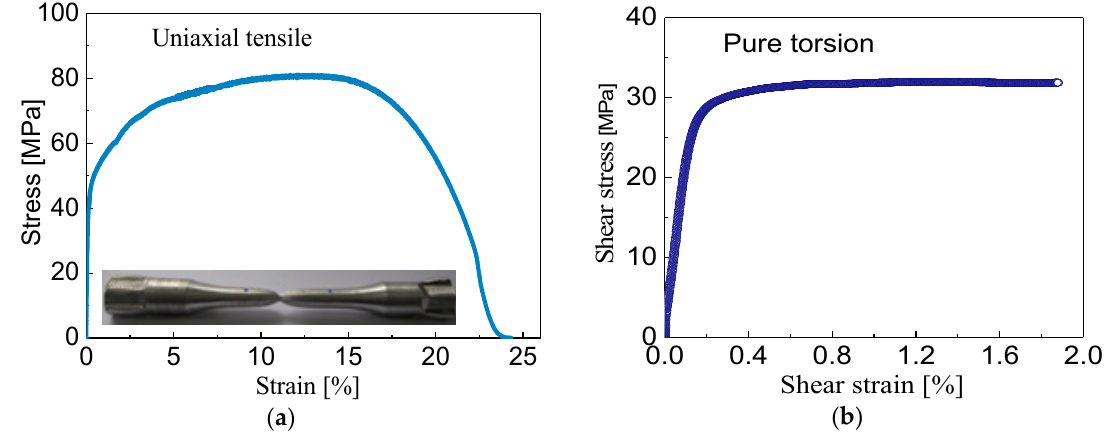
Figure 3. Stress-strain curves of polycrystalline aluminum by test: ( a ) the stress-strain response in the uniaxial tension, ( b ) the stress-strain response in the pure torsion.